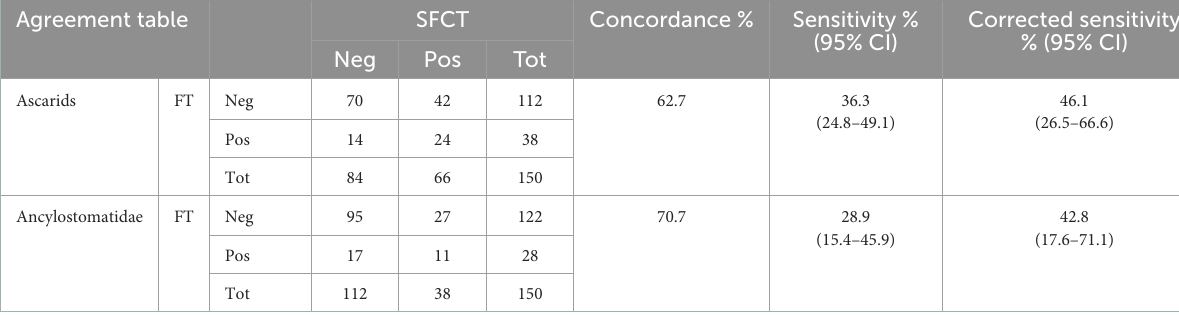
TABLE 1 Agreement table between results at SFCT (scraping, filtration and counting technique) and FT (zinc chloride floatation) for ascarids and